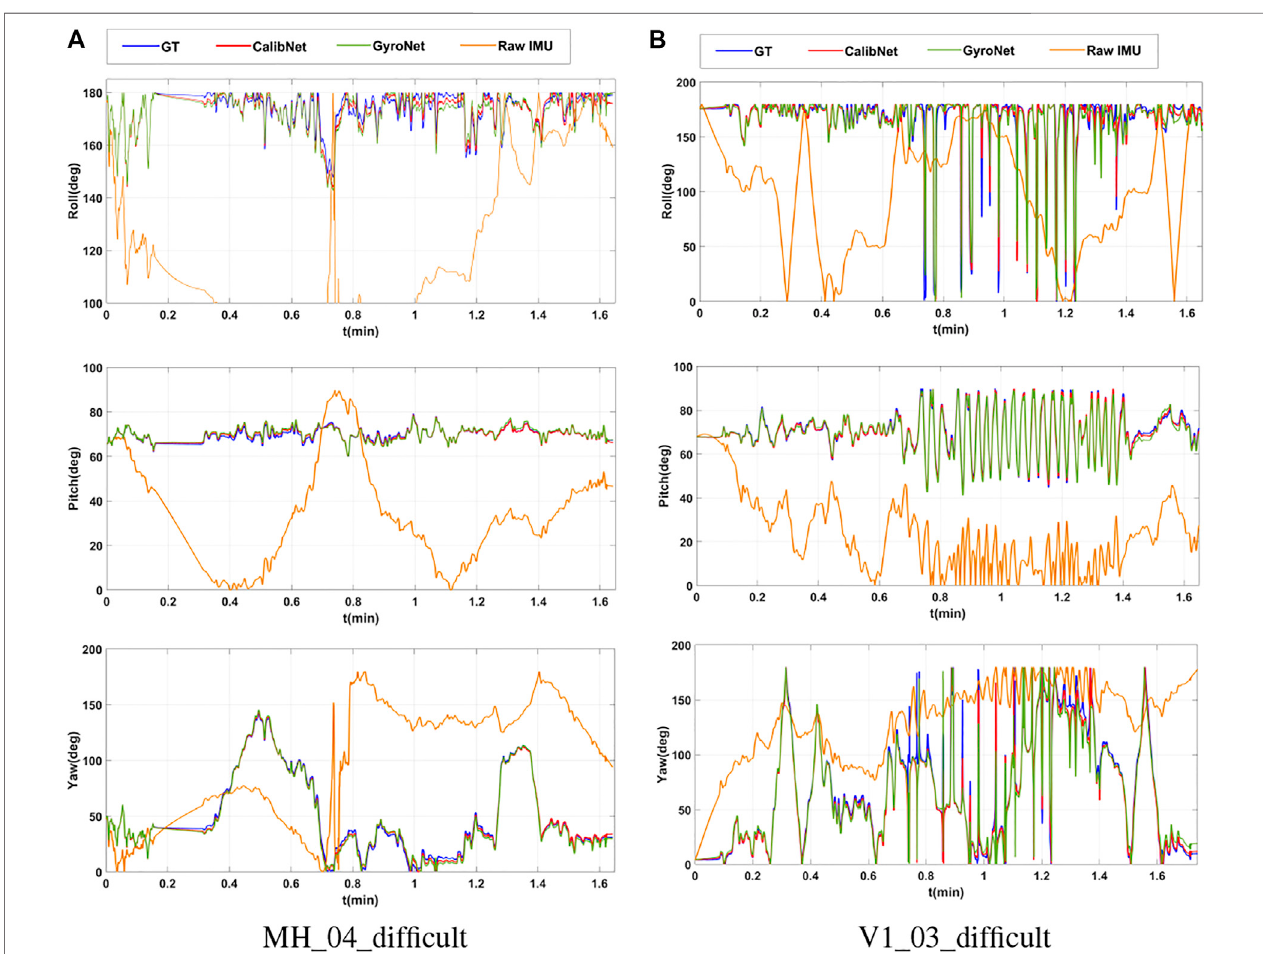
FIGURE 4 | Plots of estimated orientations with different methods. (A) Estimated orientation for MH_04_dif fi cult with different methods. (B) Estimated orientation for V1_03_dif fi cult with different learning-based methods.